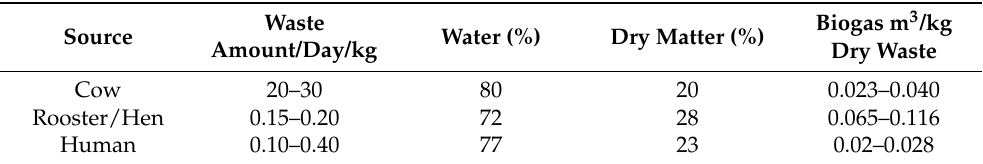
Biogas m 3 /kg Dry Waste